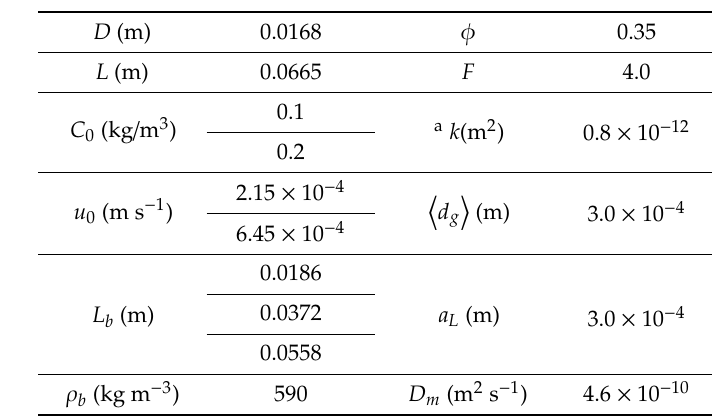
Table 7. Geometrical parameters and physical properties of the experimental system.